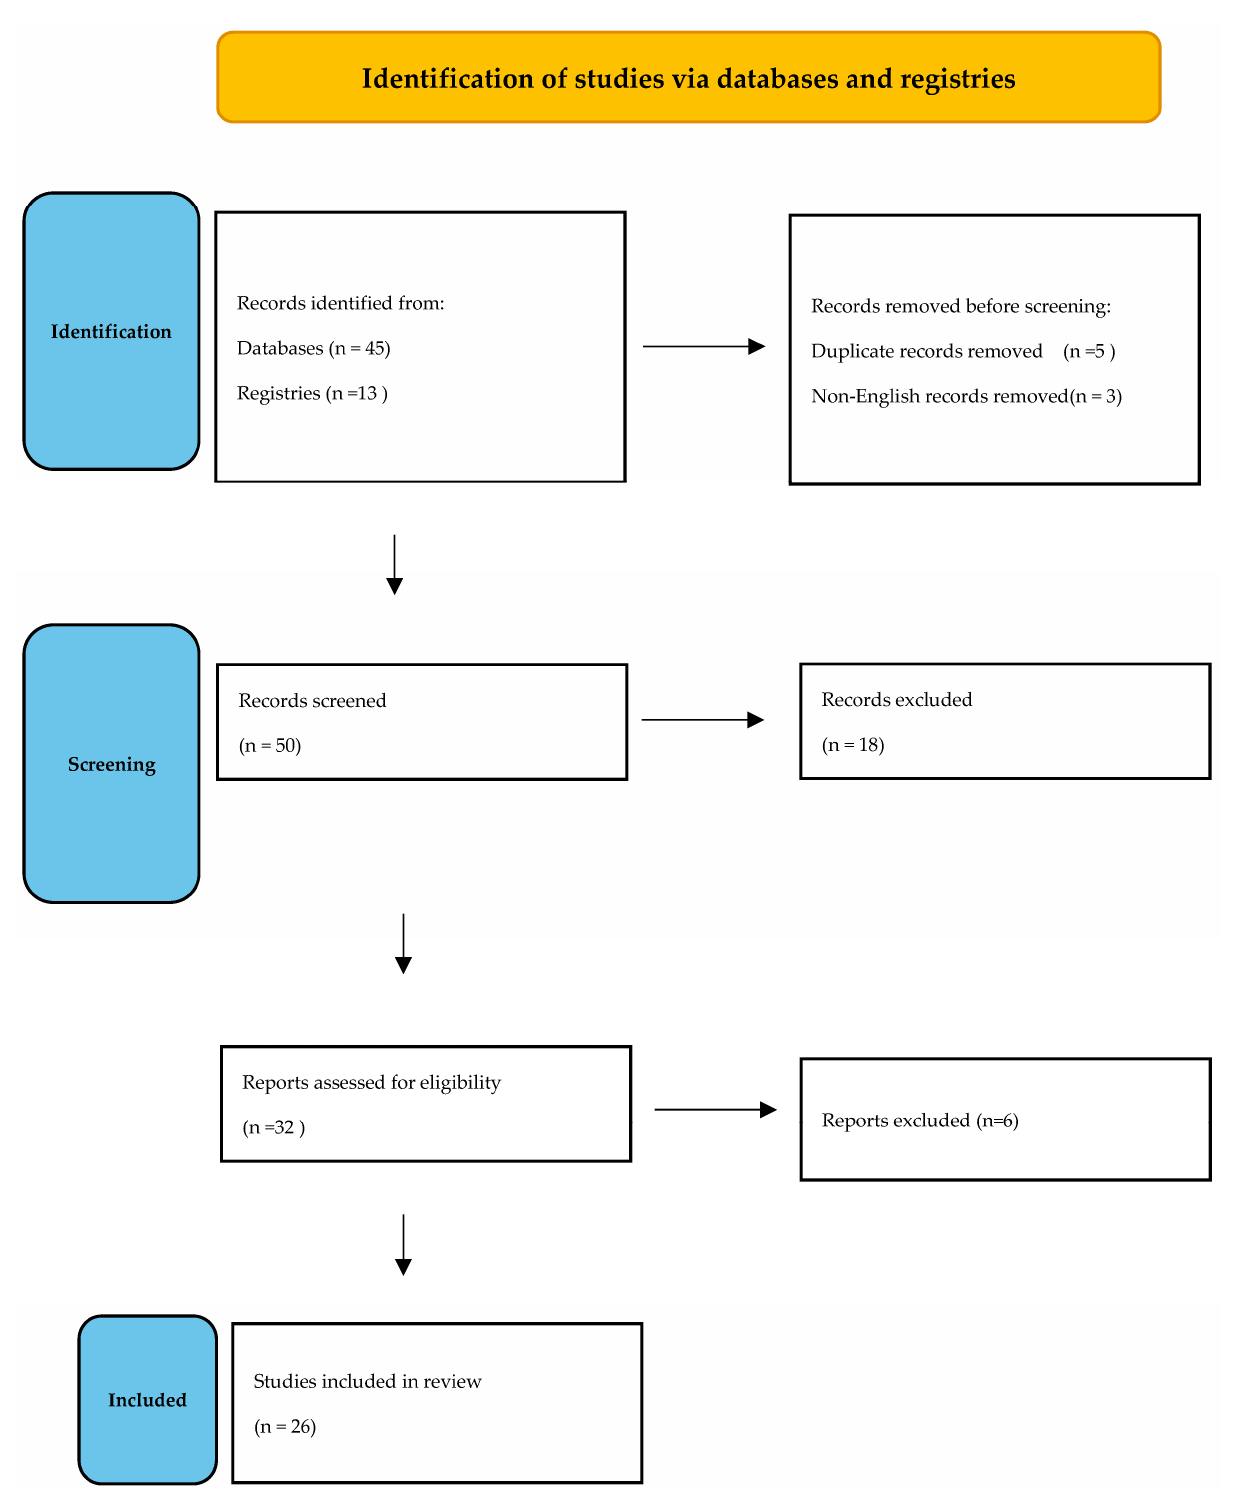
Figure 1. Search flow diagram.